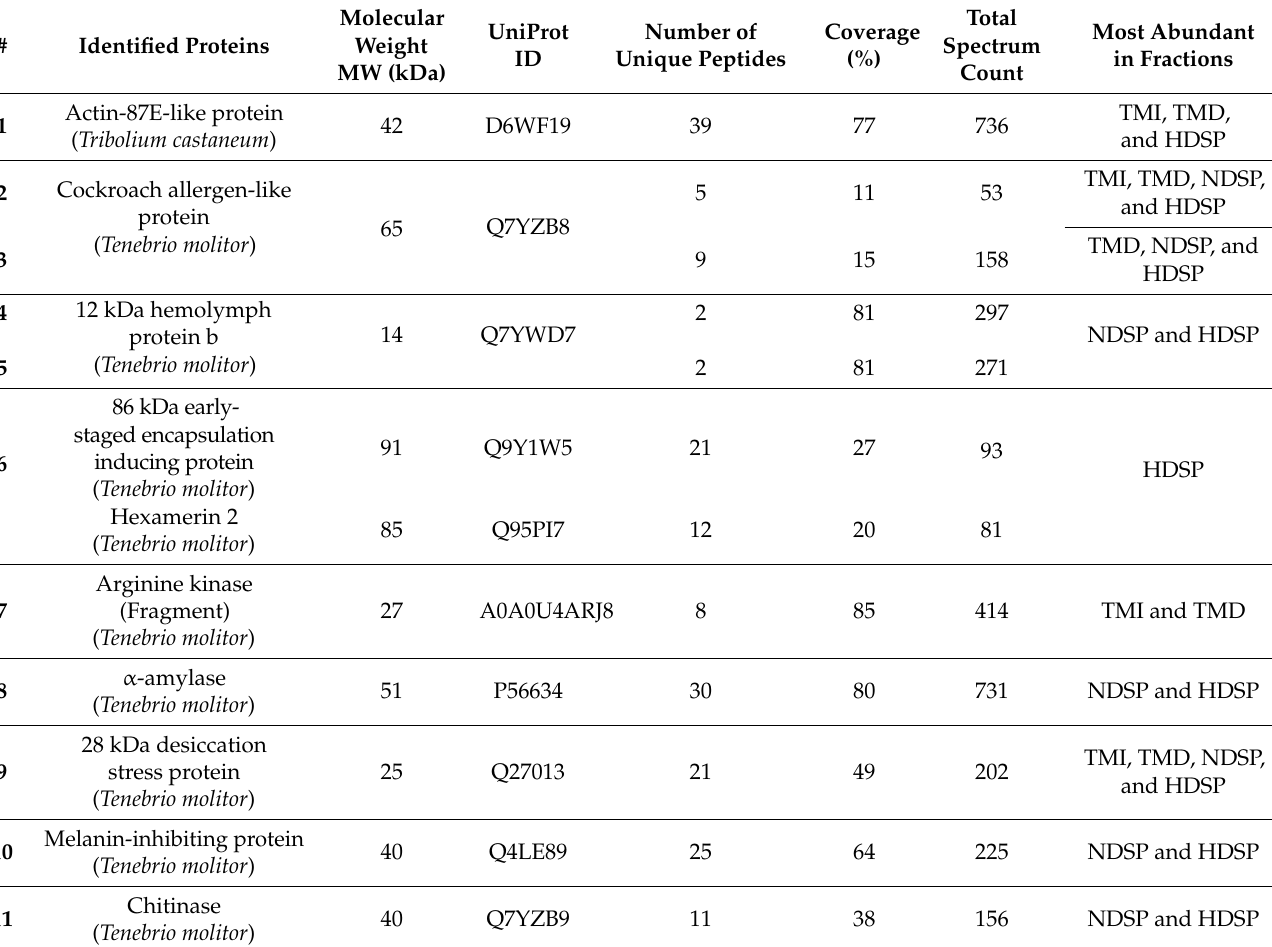
Table 2. Proteins identified by proteomics in T. molitor 2D